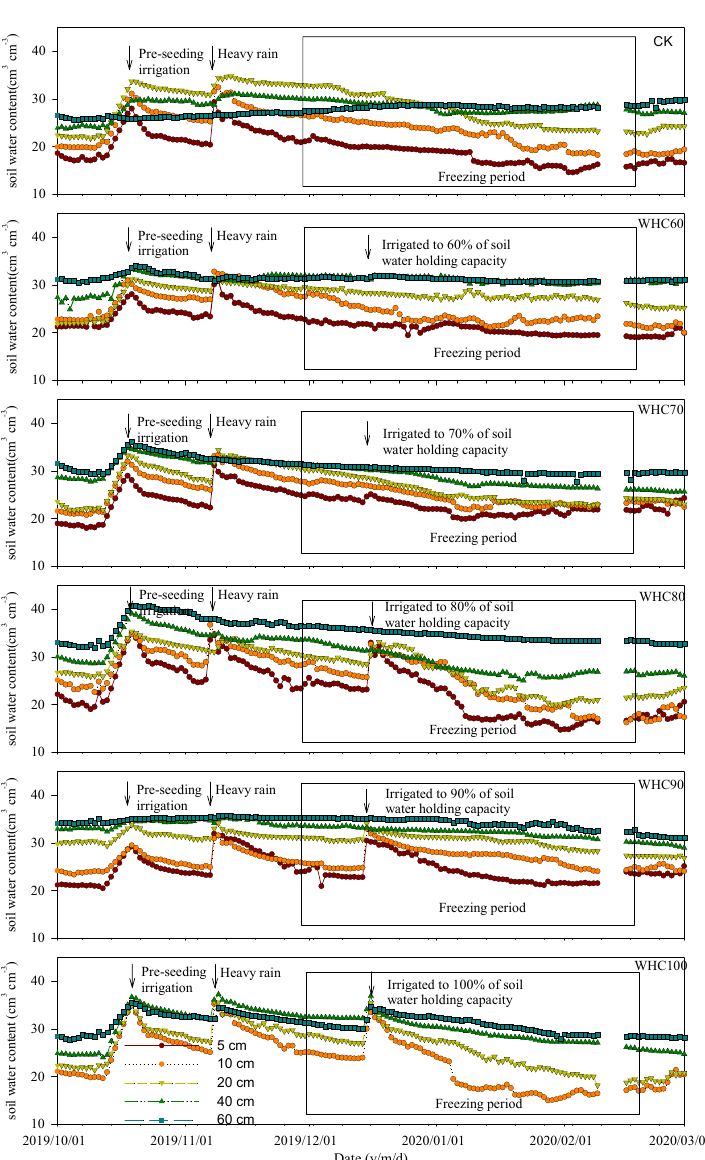
Figure 4. Soil water content at 5, 10, 20, 40 and 60 cm depths from different treatments. Arrows indicate the occurrences of pre ‐ seeding irrigation (17 October 2019), heavy rain (8 November 2019) and winter irrigation (15 December 2019). CK refers to the treatment without winter irrigation. WHC60, WHC70, WHC80, WHC90 and WHC100 refer to the treatments with winter irrigations where soil in 0–30 cm was irrigated to 60%, 70%, 80%, 90% and 100% of the soil water holding capacity on 15 December 2019,